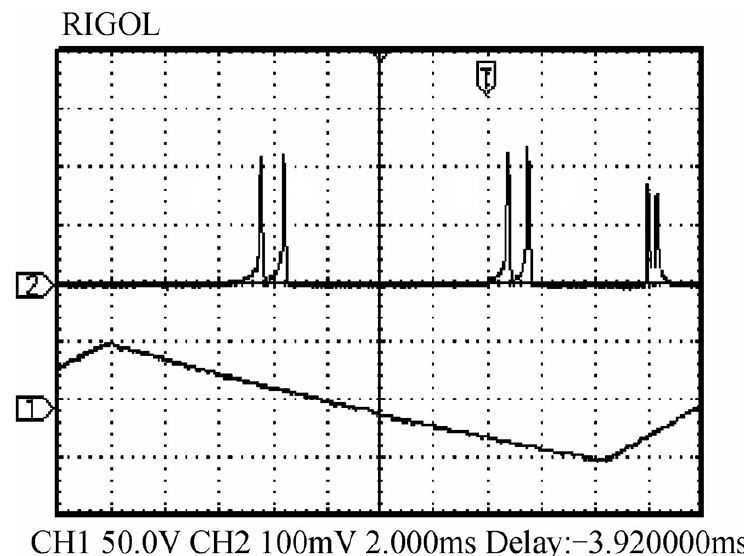
Figure 34. Oscillating-mode spectrum of dual-frequency laser [38].